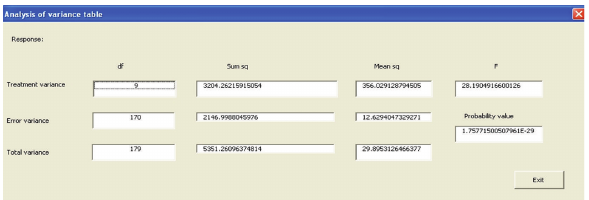
Figure 4: Analysis of variance table.